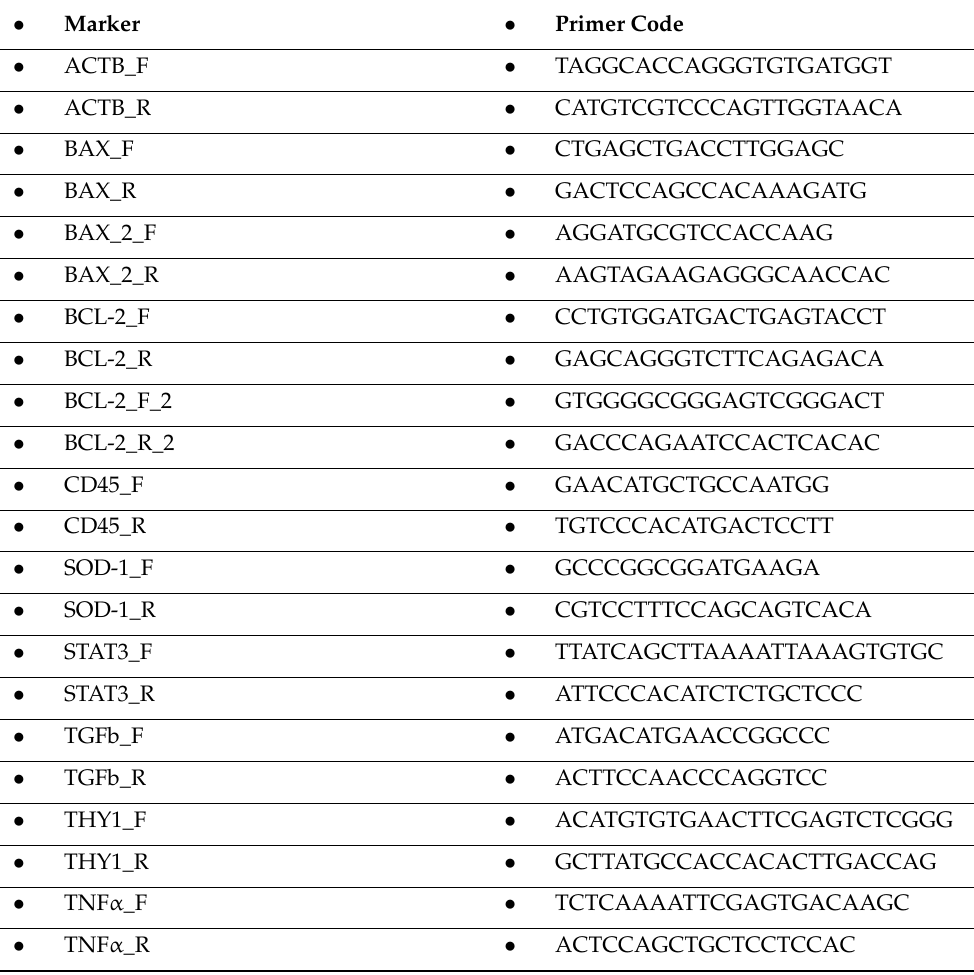
Table 2. List of primers used for the molecular